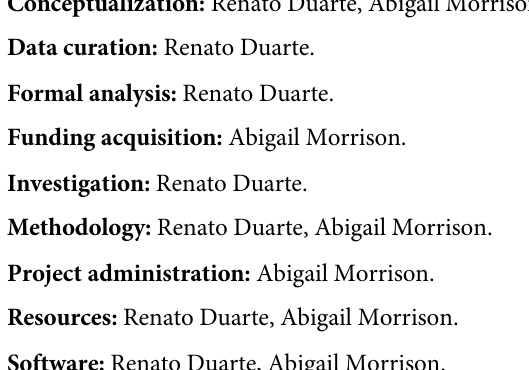
S3 Fig. Population spiking activity in the active state. Complete statistics of population spik- ing activity in the active state for the different neuron classes: E (top, blue), I (middle, red) 1 and I (bottom, orange) and for the different conditions (columns). The radial axes in each 2 plot correspond to: regularity (CV ), synchrony (CC), burstiness (ISI ), entropy of the ISI ISI 5% distribution (H ), and the mean firing rate ( ν ). All statistics were computed for an observa- ISI tion period of 10s, in a single realization for each condition, with all input parameters fixed and set to the values determined in S2 Fig. S4 Fig. Temporal receptivity of the microcircuits analysed. ( a ) capacity to reconstruct the original input signal at zero lag (i.e. maximum polynomial degree d = 1, maximum delay k = 0, C ) as a function of the signal resolution ( Δ t ). Since the capacity values converge asymp- d=1,k=0 totically to 1, we determine the optimal resolution as the minimum Δ t at which C � d=1,k=0 0.99. ( b ) Decoding capacity at minimum resolution Δ t = 0.1 ms (equal to the simulation reso- lution). ( c ) Capacity at the maximum resolution tested ( Δ t = 20 ms). ( d ) Optimal resolution for each condition. All results correspond to the mean and standard deviations for 10 simula- tions per condition. S1 File. Software